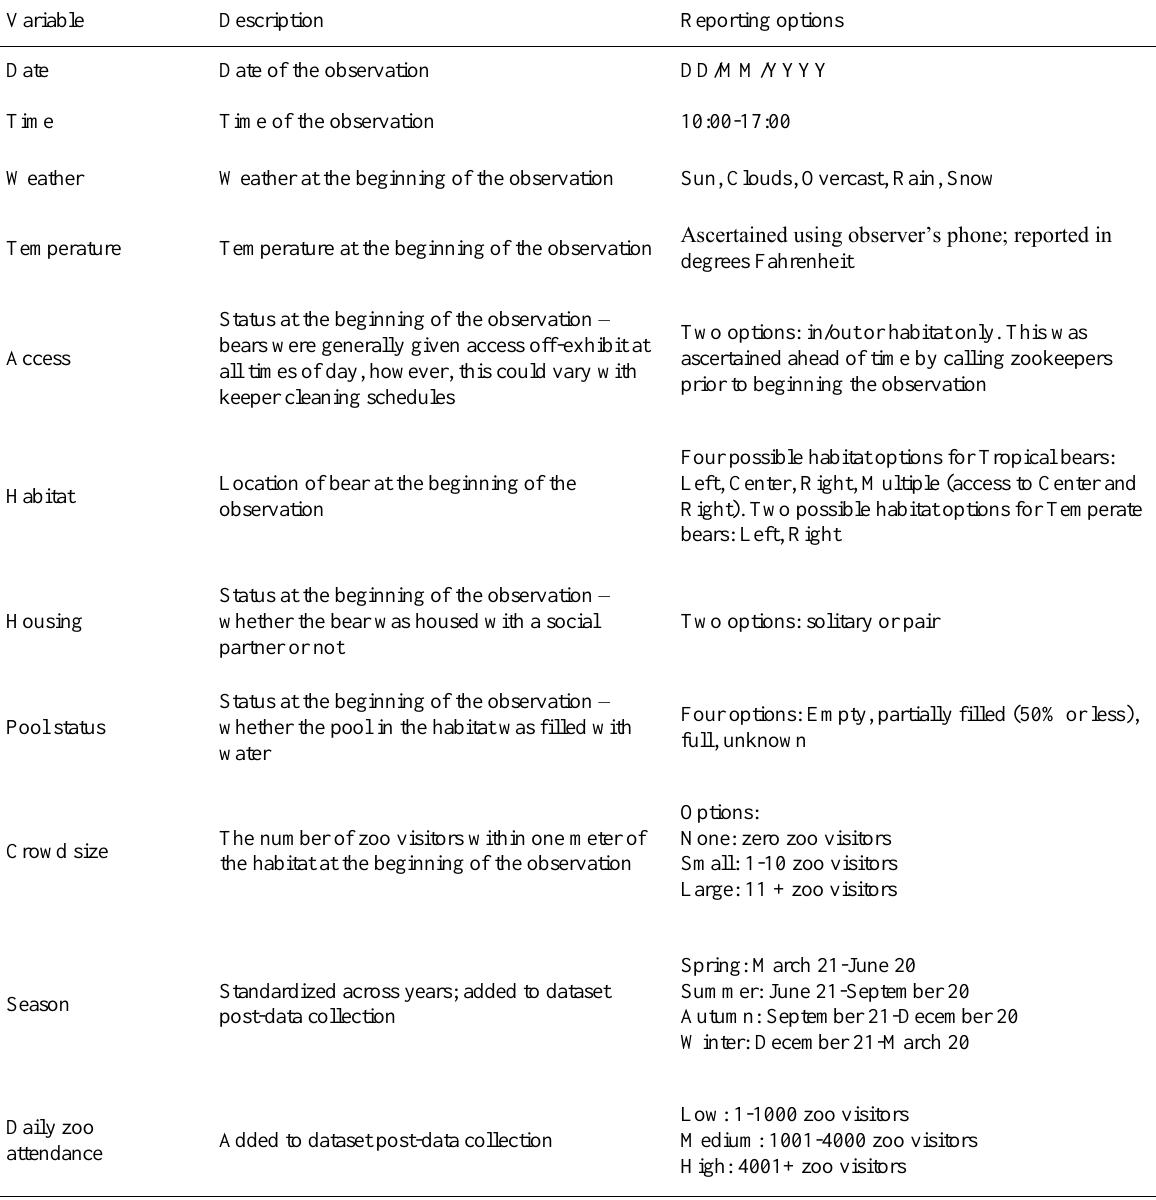
Independent Variables Collected by Observers at the Beginning of each Focal Observation Variable